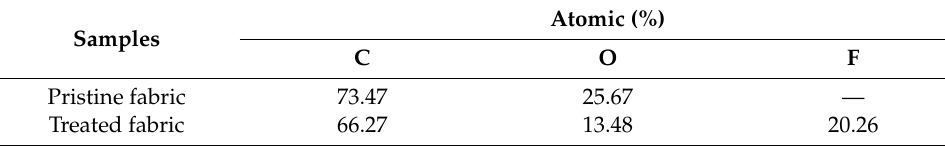
Figure 10. XPS full spectrum of pristine cotton fabric ( A ) and treated fabric ( B ). Table 1. The content of surface functional groups ascertained by XPS.